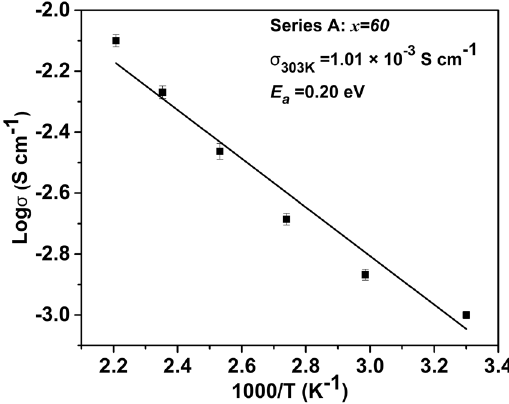
Figure 7. Temperature dependence of the conductivity of 40(0.2Ga 2 S 3 -0.8Sb 2 S 3 ) − 60AgI